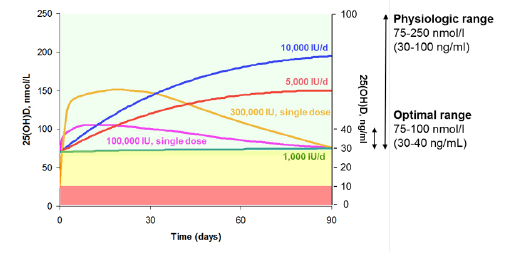
Figure 8: Changes in serum 25(OH)D levels over time after differ- ent supplementation dose regimens during winter*. For all health endpoints considered by Bischoff-Ferrari et al [1], the most advan- tageous serum concentrations of 25(OH)D begin at 75 nmol/l (30 ng/ml), and the best are between 90 and 100 nmol/l (36–40 ng/ml). For most people living in urban areas, this optimal range can be reached with a supplementary cholecalciferol (vitamin D3) dose of 3000 IU daily (alternatively 20 000 IU weekly or 80 000 IU monthly; 1 IU = 0.025 µg vitamin D3; 1 µg vitamin D3 = 40 IU). A loading dose followed by maintenance doses at regular intervals can be considered on an individual base. Serum 25(OH)D determination at baseline and after supplementation may be required for dose adjustment; sub-sequential 25(OH)D determinations are usually not required.*The data used to prepare this graphic were obtained from previous reports